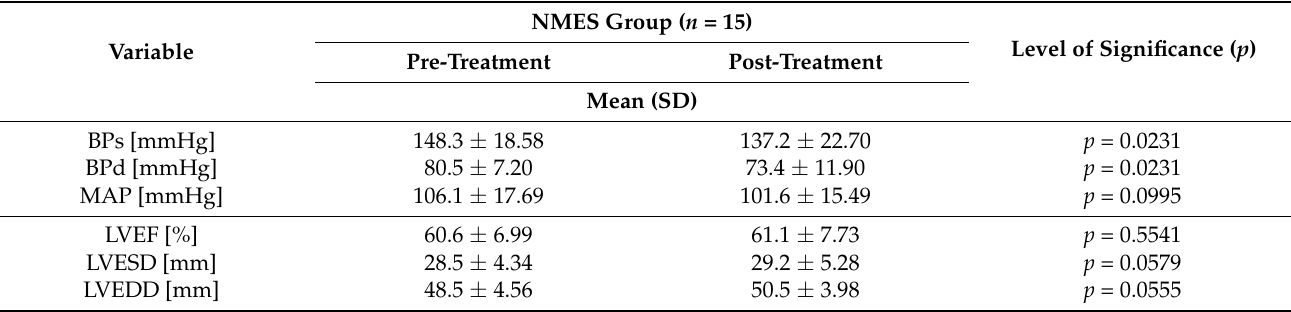
Table 4. Mean daily arterial blood pressure and echocardiographic parameter values before and after 12 weeks of interven- tion ( n =